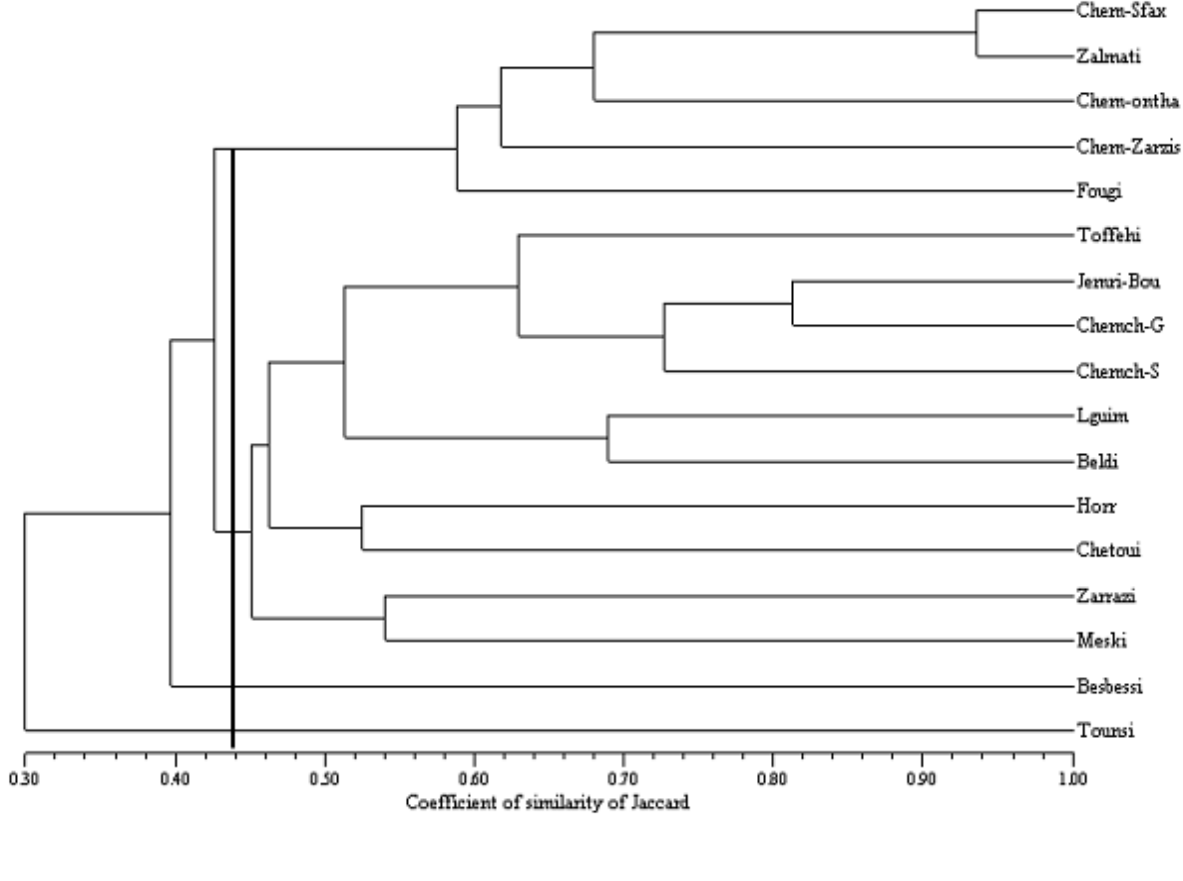
Figure 3. Consensus Dendrogram of 16 olive cultivars based on both SSR and SNP